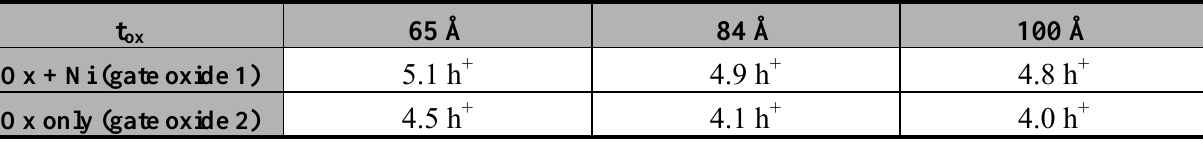
Table 3. Temporal noise (in equivalent holes) corresponding to different oxidation process